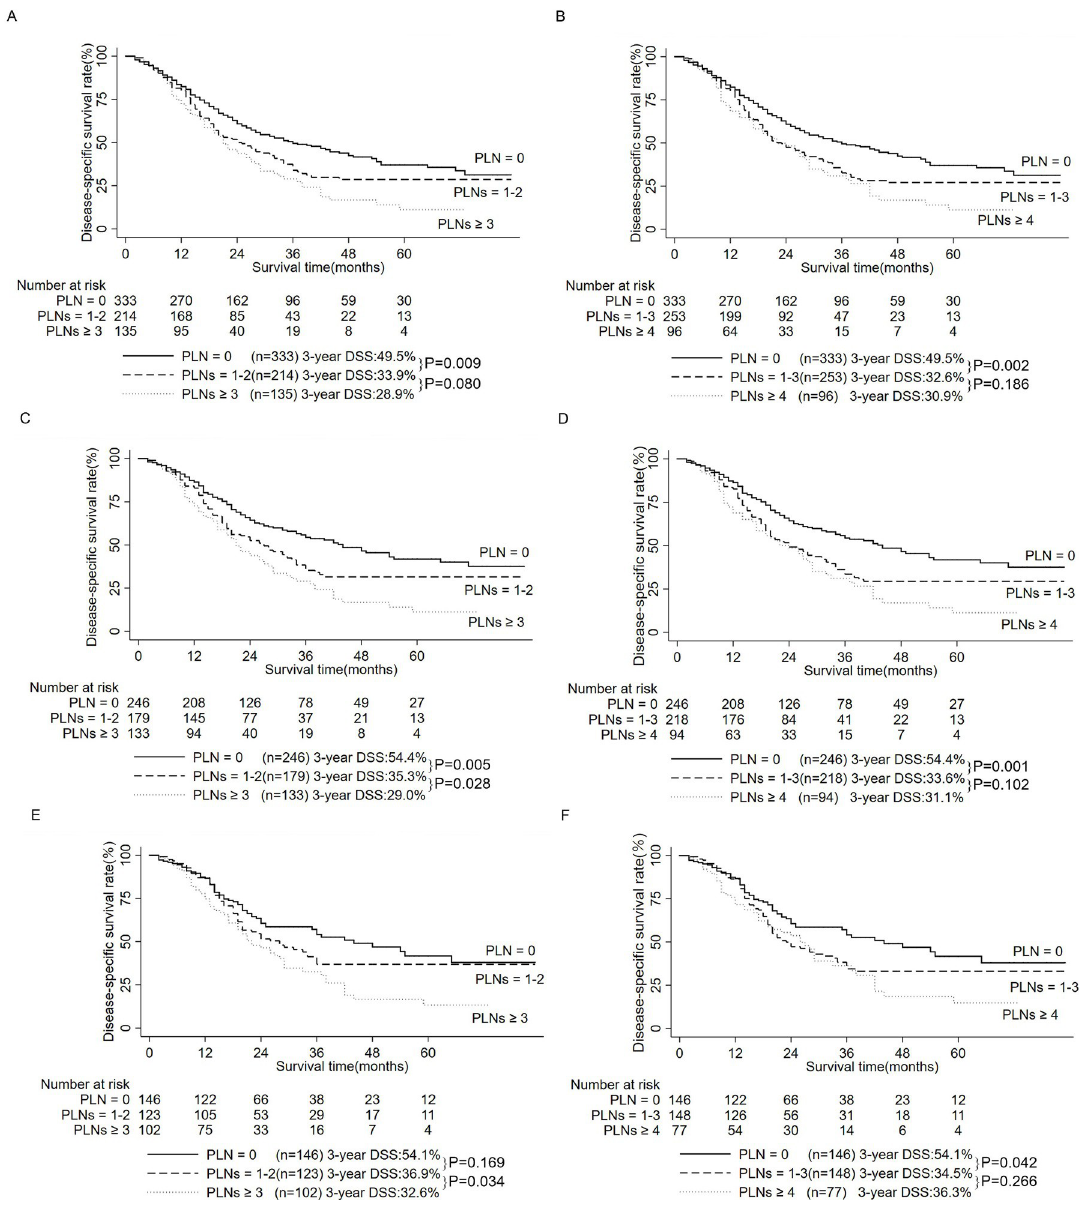
Fig 2. Survival analysis comparing the different numbers of PLNs. A: Survival analysis comparing the optimal cut-off value of the number of PLNs (0, 2) in M0 patients with ELNs � 1 (n = 682). B: Survival analysis comparing the recommendation of the number of PLNs by the AJCC (0, 3) in M0 patients with ELNs � 1 (n = 682). C: Survival analysis comparing the optimal cut-off value of the number of PLNs (0, 2) in M0 patients with ELNs � 5 (n = 558). D: Survival analysis comparing the recommendation of the number of PLNs by the AJCC (0, 3) in M0 patients with ELNs � 5 (n = 558). E: Survival analysis comparing the optimal cut-off value of the number of PLNs (0, 2) in M0 patients with ELNs � 12 (n = 371). F: Survival analysis comparing the recommendation of the number of PLNs by the AJCC (0, 3) in M0 patients with ELNs � 12 (n =